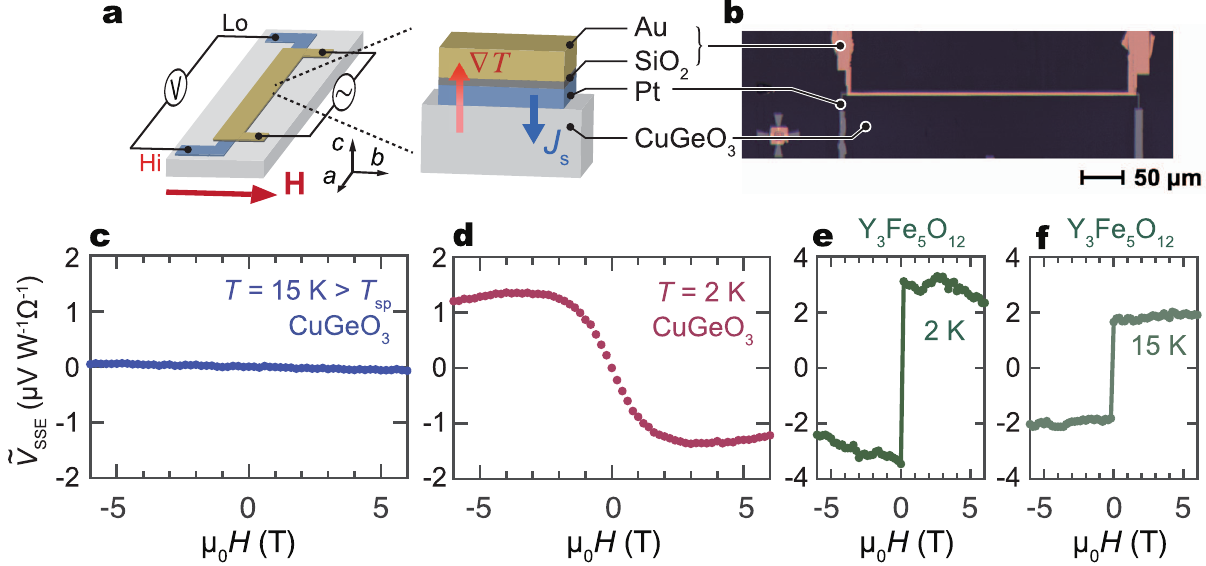
Fig. 2 SSE measurement results for CuGeO 3 /Pt. a Experimental setup for the SSE measurement. Temperature gradient ( ∇ T ) is applied by using an Au heater electrically insulated from the Pt layer by a SiO 2 fi lm. An a.c. current is applied to the Au heater and SSE voltage in the Pt is measured with a lock-in ampli fi er as the second harmonic voltage V 2 f . b An optical micrograph for a on-chip SSE device made on the top of CuGeO 3 . c , d The magnetic fi eld ( H ) dependence of ~ V SSE (the SSE signal normalized to the heating power and the detector resistance) for the CuGeO 3 /Pt sample at 15 and 2 K, respectively. e , f ~ V SSE ð H Þ measured for Y 3 Fe 5 O 12 /Pt at 2 and 15 K.